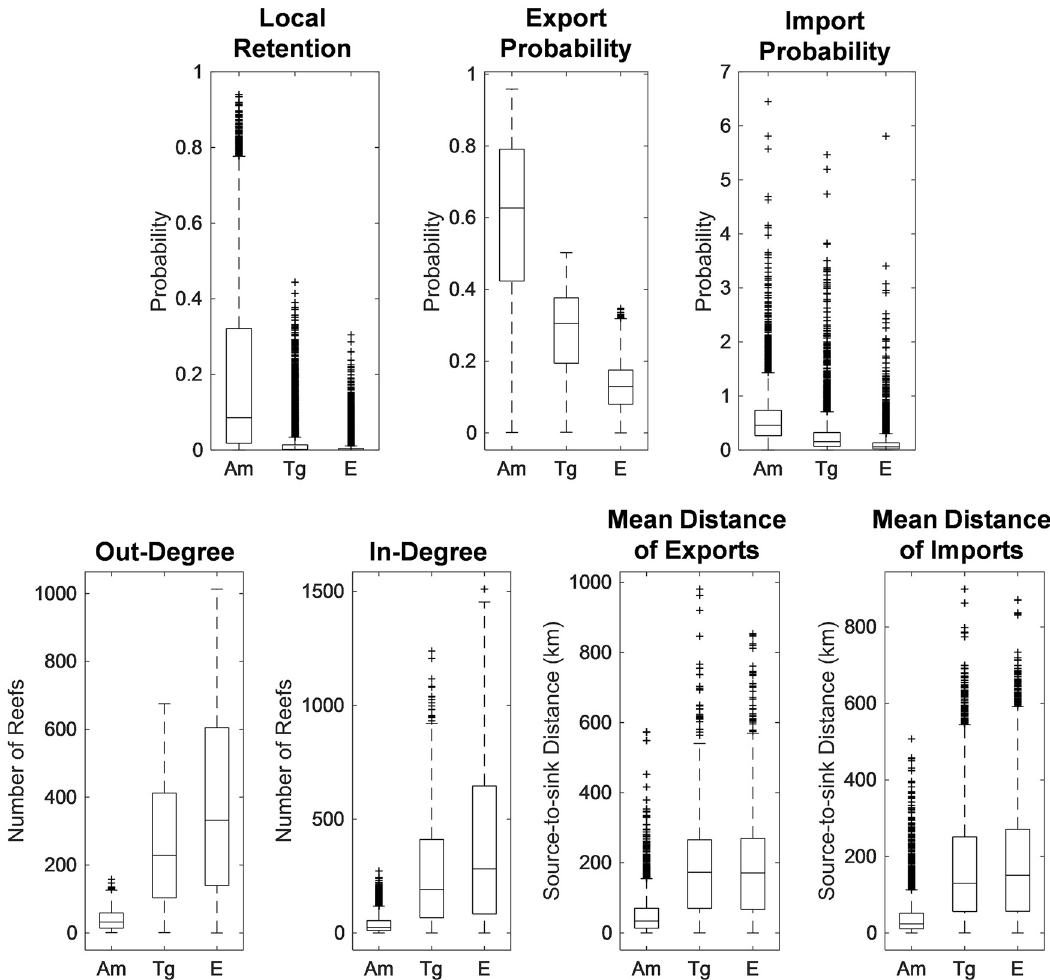
Fig 3. Comparison of connectivity metric distributions between organisms. All distributions were significantly different (p < 0.001). Am: Acropora millepora , Tg: Tripneustes gratilla , E: Epinephelus sp. Boxes display the first and third quartile spread of the data, the central line indicates the median, and the whiskers and outliers denote the range of values.